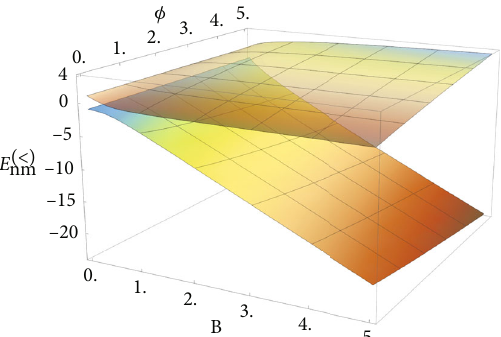
Figure 10: Sketch of the energy (Equation (71)) as a function of B and ϕ for a = 1 , α = 0 : 5 , m = 1 , and n = 1